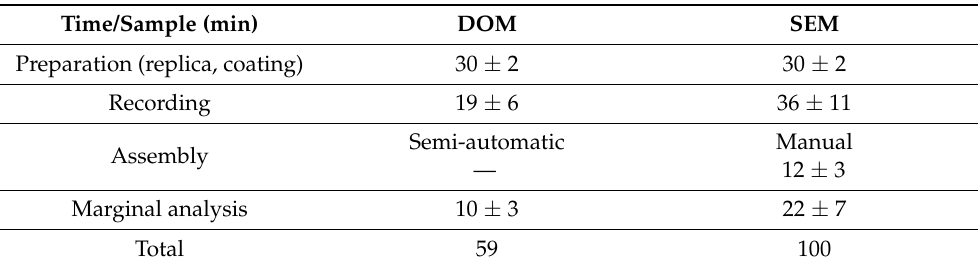
Table 1. Required time ( ± SD) for each step of the marginal analysis procedure calculated as a mean value from the fifteen evaluated